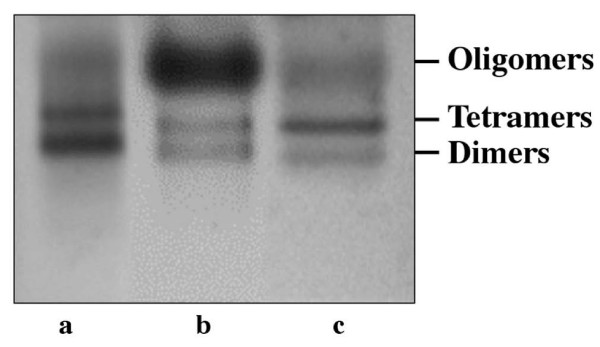
Electrophoretic analyses of crude spectrin extracts from patients (a = IV:1 RM23; b = IV:1 RM16) and control (c).